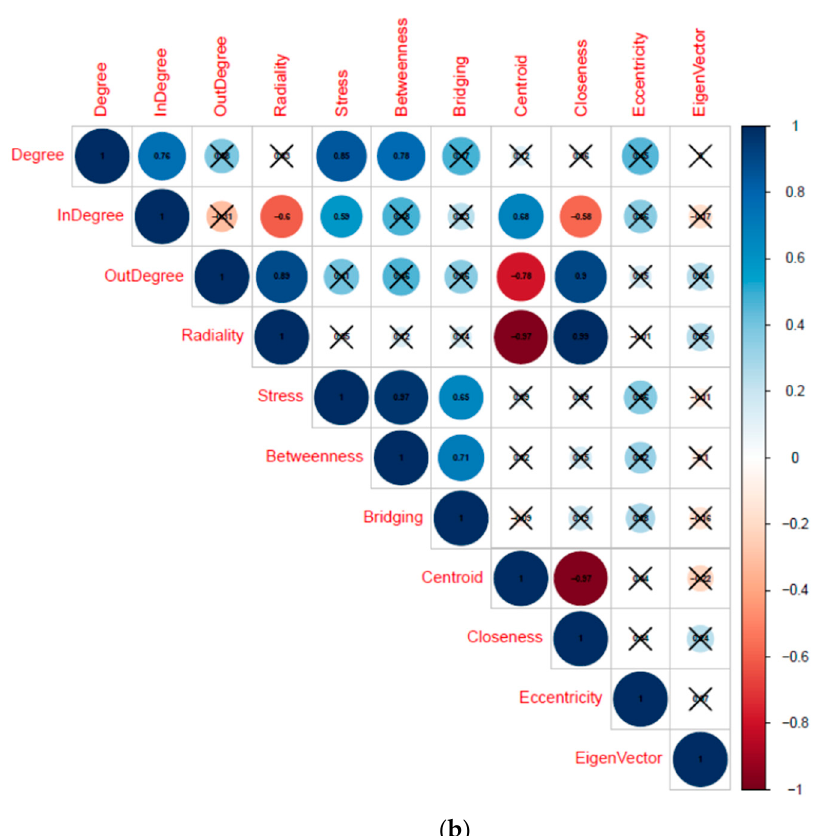
Figure 4. ( a ) Topological analysis of the extended regulatory network. Each panel represents the scatterplot of the index ‐ over ‐ index topological measures calculated for the extended regulatory network. To draw the representative scatterplots, only one index was chosen among those that were highly correlated and with very similar meanings. The presence of a non ‐ uniform distribution of nodes, with most nodes having a low index and a few having a high index, identifies those nodes that clearly di ff er from the average measure of the index throughout the network (red and orange dots or labels). Red, orange, and blue colors, respectively, refer to nodes with z-scores > 2.0, between 1.5 and 2.0, and < 1.5. Detailed results are reported in Data Supplement 1e. ( b ) Correlation plot of the topological indexes. Indexes with similar meanings show a highly significant Pearson’s correlation ( p -values < 0.001). Numbers and circle sizes (from smaller to bigger) refer to correlation coe ffi cient r values. Positive and negative correlations are displayed by a gradient color from white (low) to blue (high) and from white (low) to red (high), respectively. To simplify visualization, crosses mark non-significant correlations.